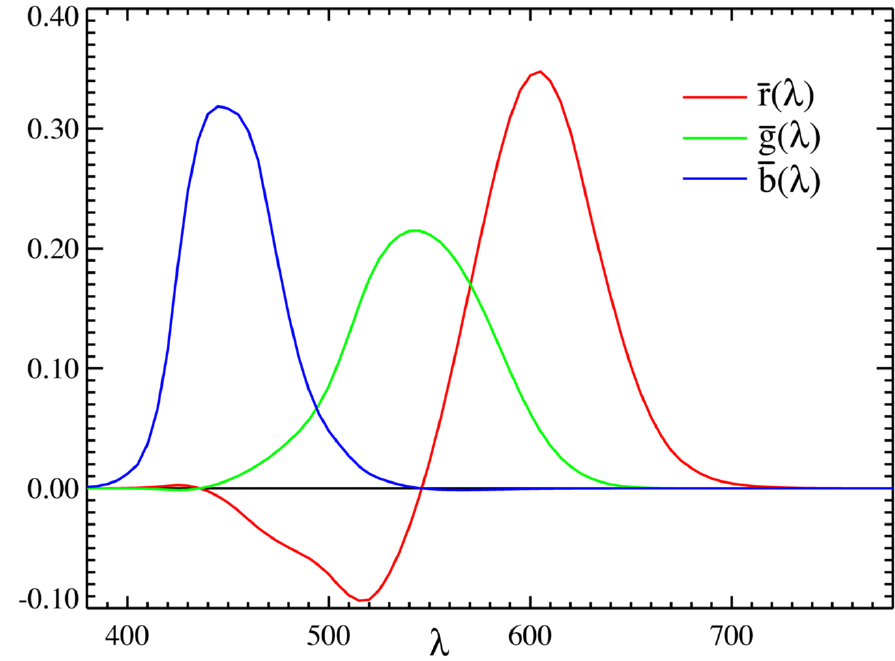
Figure 2. The CIE 1931 RGB color matching function [24].